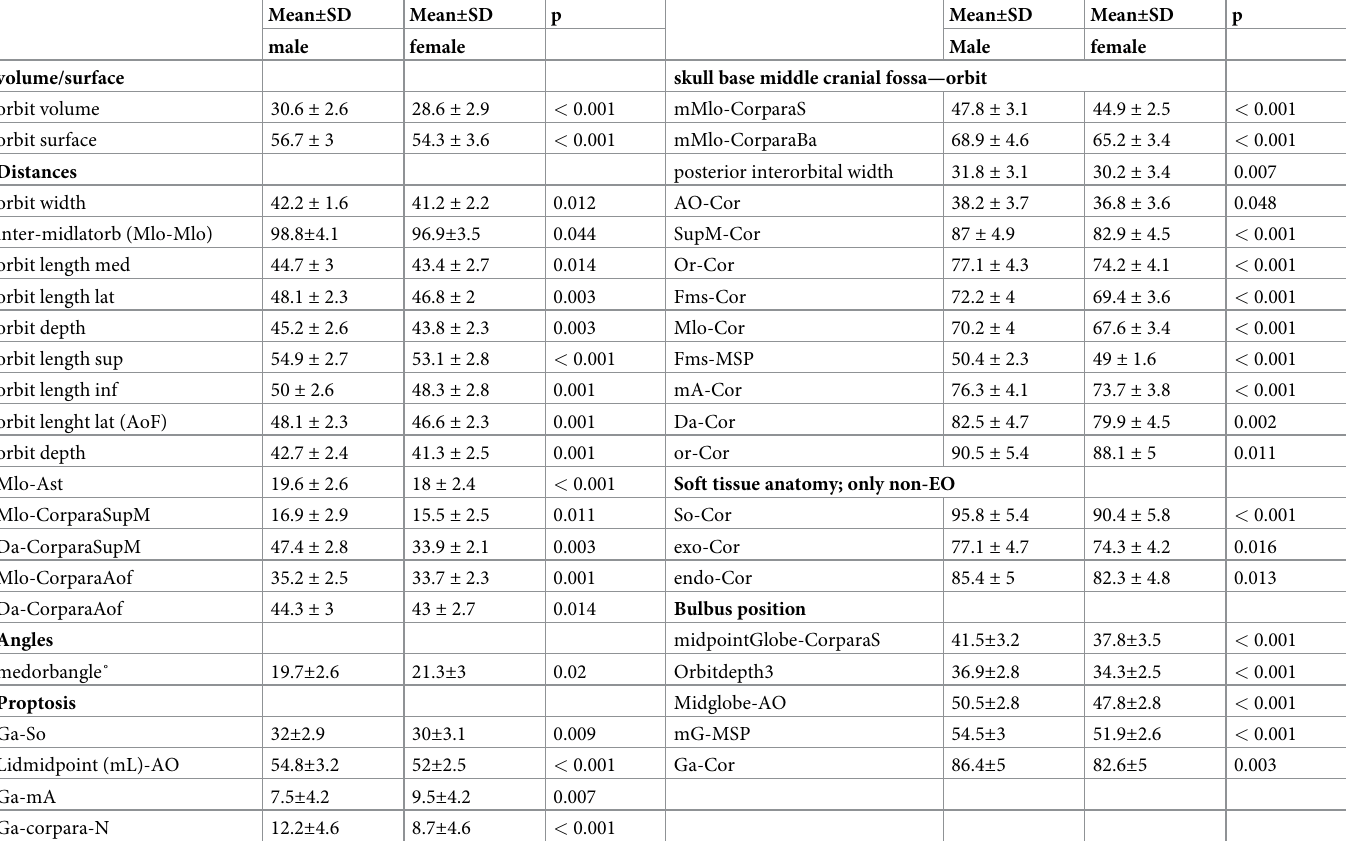
Table 4. Sex differences. Bony measurements include all CT scans, whereas soft tissue variables were made for the nonEO group